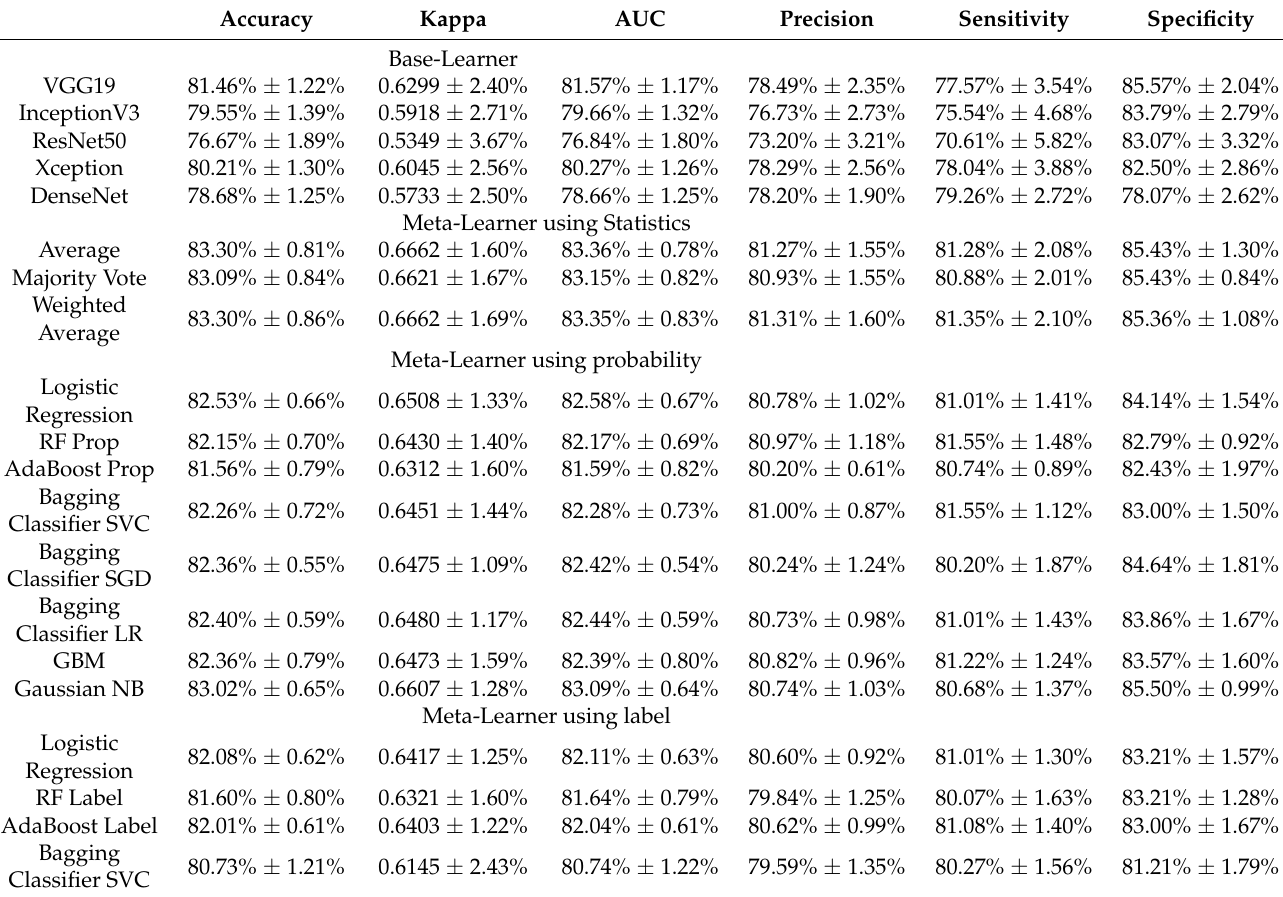
Table A1. The Kappa score achieved by each classifier of the test set for the humerus images ( ± Confidence Interval 95%). Test performance is